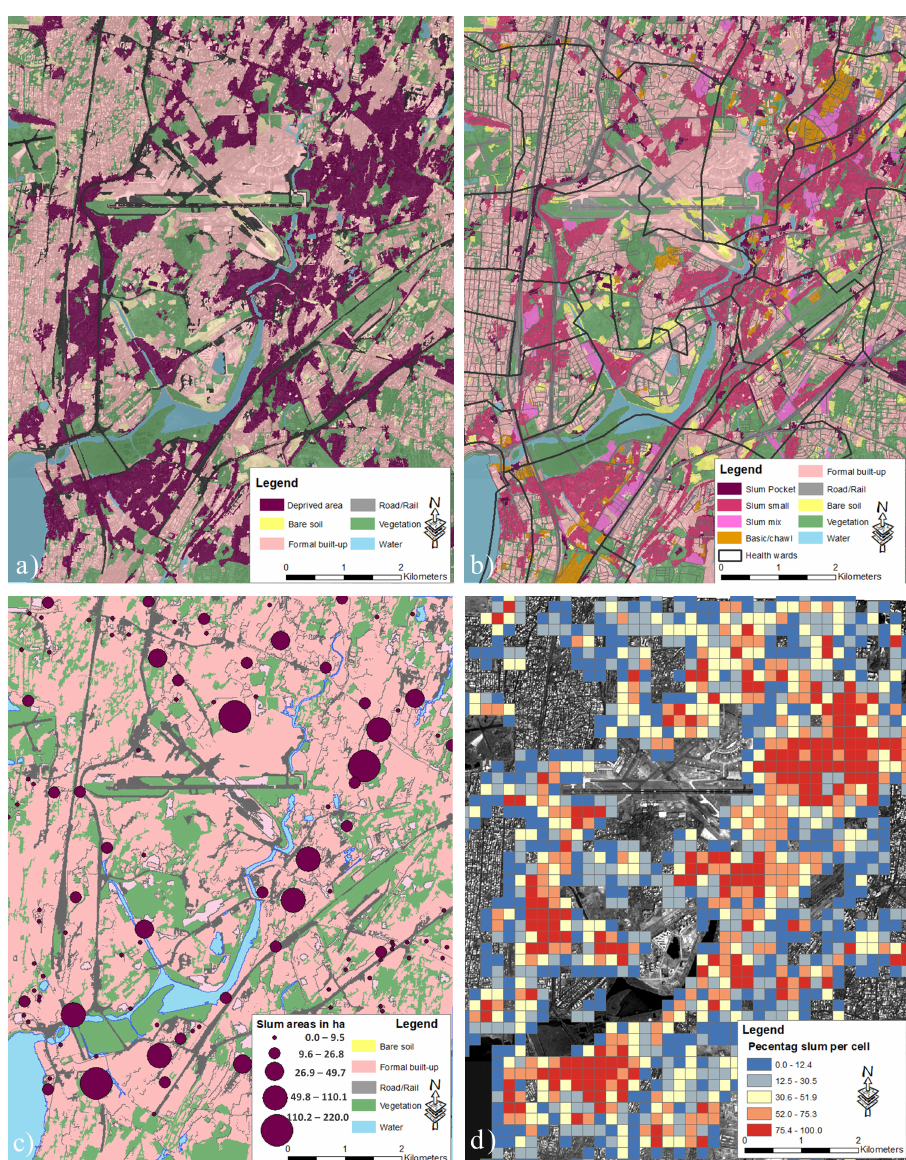
Figure 14. Different spatial information levels of deprived areas: ( a ) deprived areas mapped together with other land cover/use; ( b ) detailed urban deprivation classes; ( c ) point locations of deprived areas and size; and ( d ) percentage of deprived areas within 200 × 200 m grid cells (Image source: WorldView-2 provided by